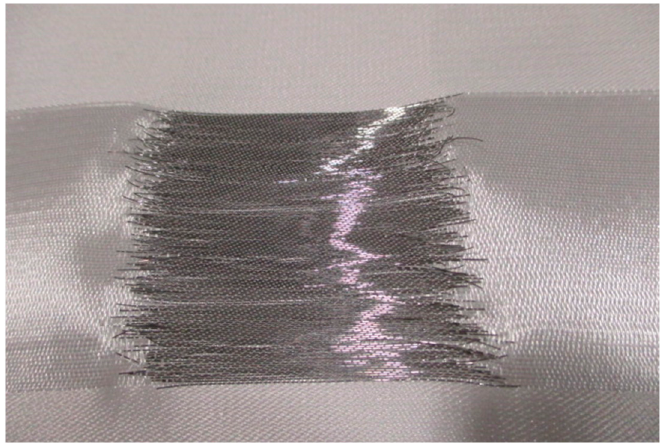
Figure 1. Fabric made of Fe–Co and polyester fibers.